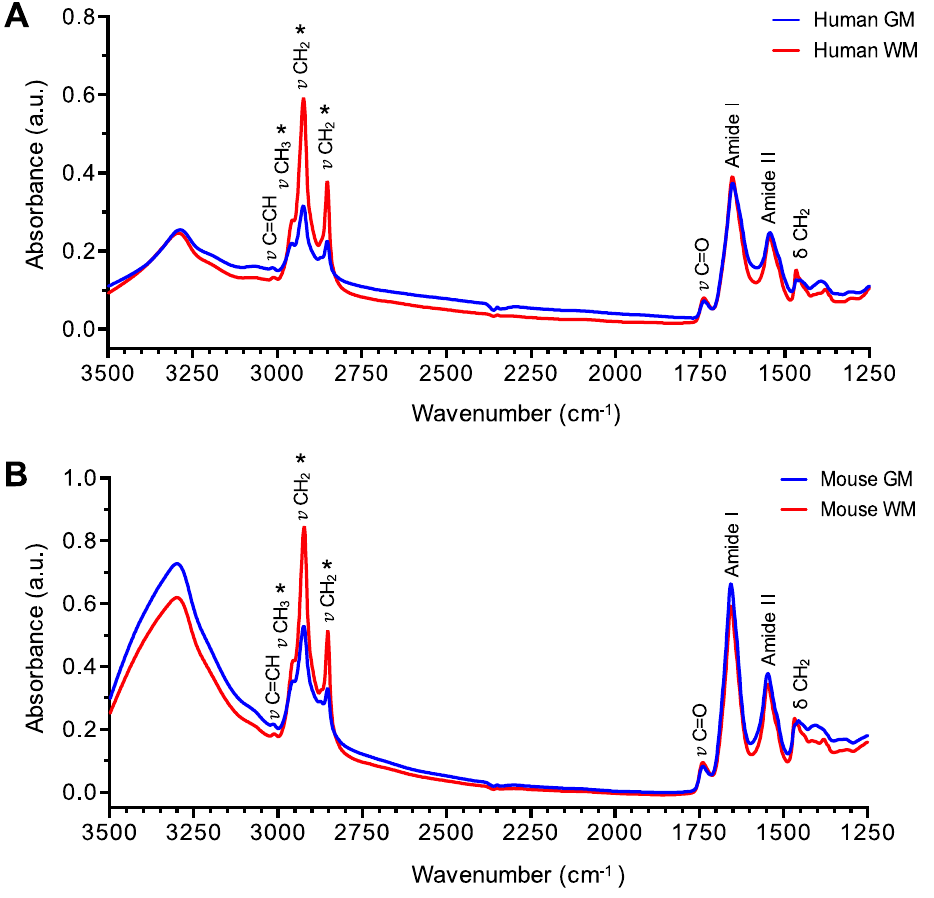
Figure 1. µ FTIR profile of grey matter (GM) and white matter (WM). Spectra of GM (blue line) and WM (red line) areas were collected and average for human ( A ) and mouse ( B ) brain samples. Note the increased absorptions of CH 2 and CH 3 peaks (*) in WM with respect to GM. a.u.—arbitrary units.